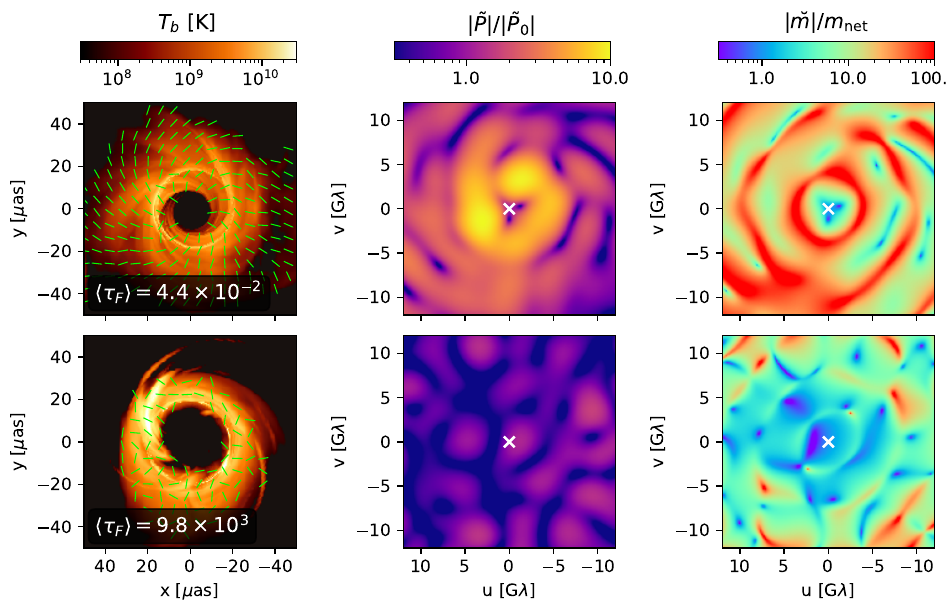
Figure 8. Two GRMHD models imaged at 228 GHz and corresponding maps of linear polarization in visibility space. The top row corresponds to a MAD model of M87* with a • = 0.9 and R high = 1, while the bottom row corresponds to a SANE model with a • = − 0.3 and R high = 40. Due to a much larger Faraday depth, written at the bottom of the images, the SANE model exhibits a much more disordered linear polarization pattern. In the ordered model, measures of the linear polarization rise dramatically with radius in the Fourier domain, while the disordered model is characterized by blobs with a coherence length corresponding to the size of the